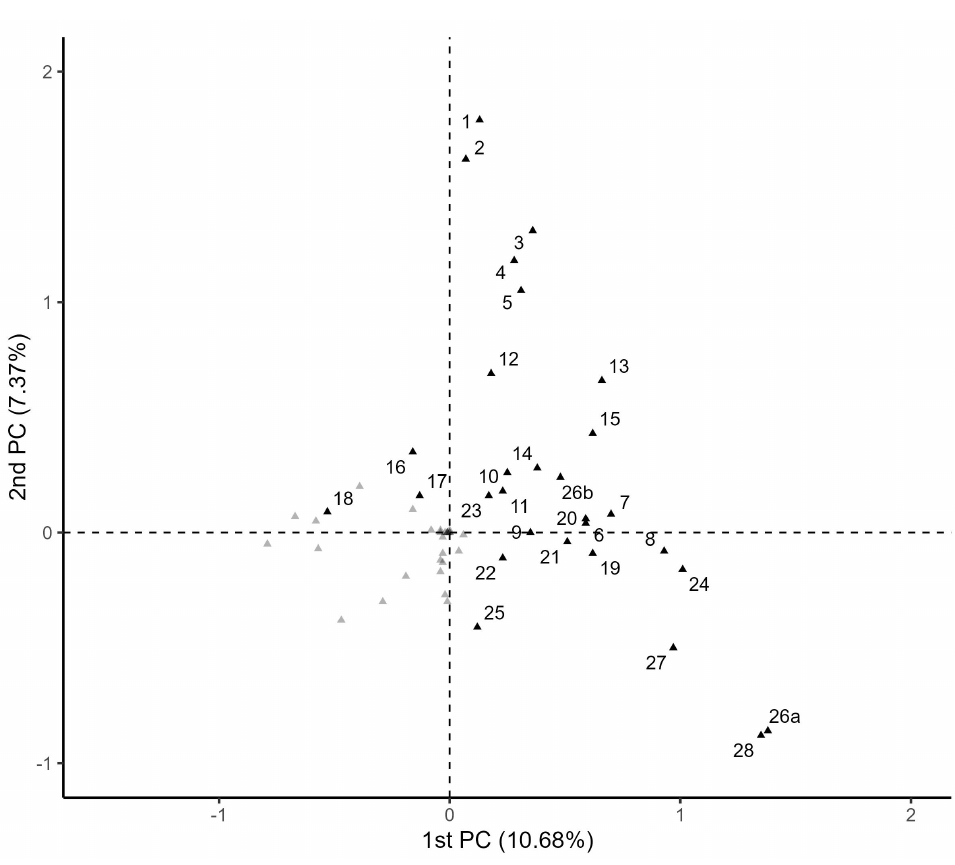
Figure 1. Multiple correspondence analysis results for the first and the second principal component (PC). The black dots are “yes” categories, numbered according to the variable labels presented in the methods section. Gray dots correspond to the “non − occurrence” category for symptoms, comorbidities, or hospital